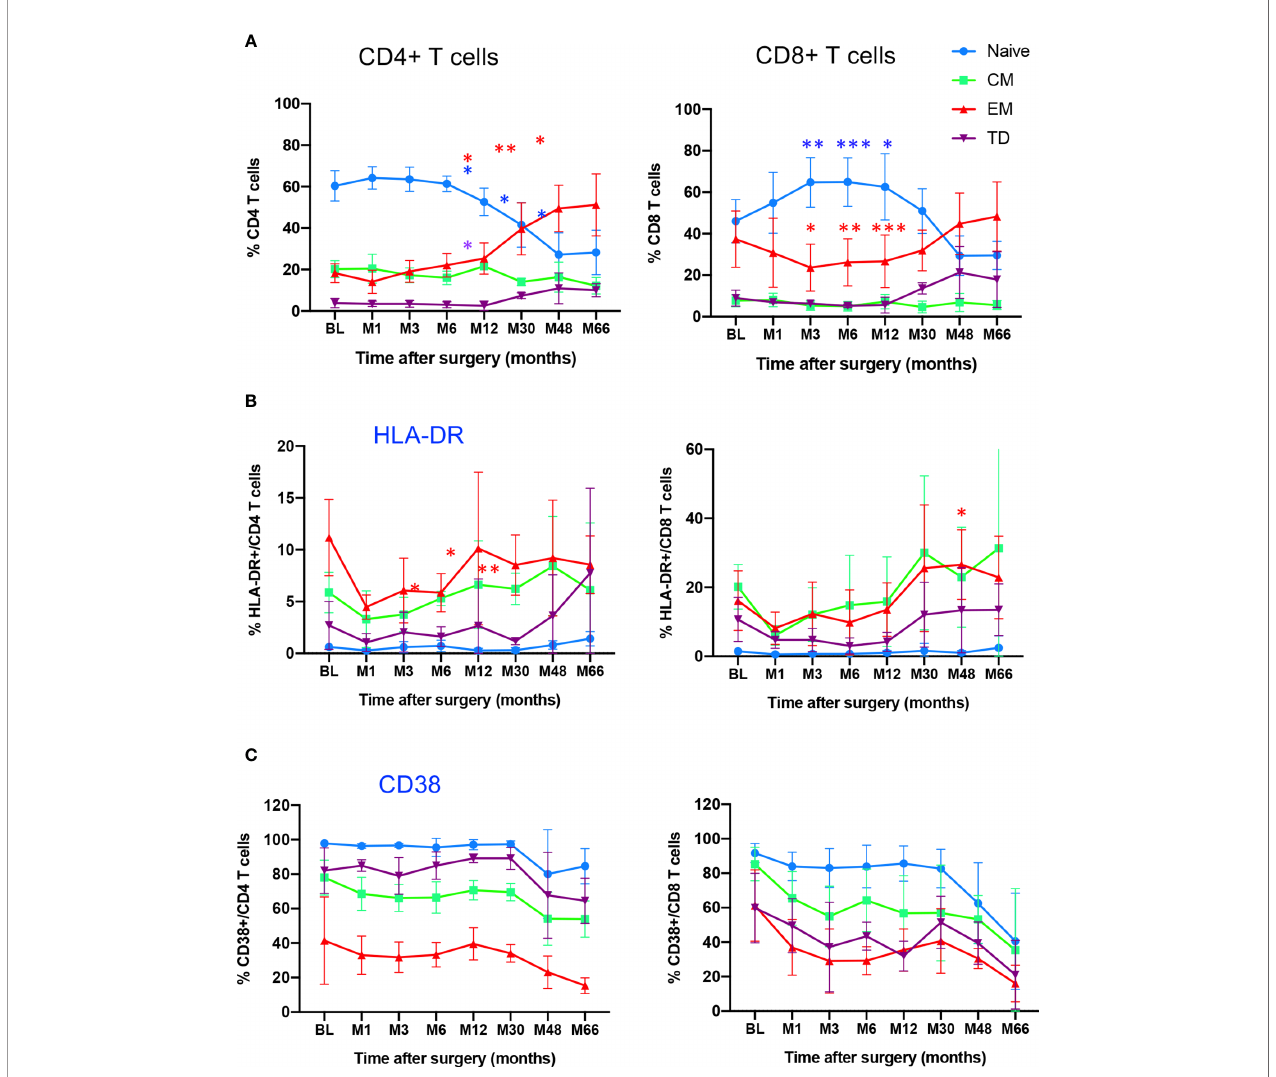
FIGURE 2 | Time course distribution and activation state of memory/effector CD4 + and CD8 + T cells. (A) Whole blood distribution of naïve/memory/effector subsets in CD4 + and CD8 + T cells. The percentage of cell subsets within CD4 + and CD8 + T cells are shown at indicated time points. (B) HLA-DR expression in indicated subsets within CD4 + and CD8 + T cells. (C) CD38 expression in indicated subsets within CD4 + and CD8 + T cells. N, naïve, CM, Central Memory; EM, Effector Memory; TD, Terminally Differentiated, identi fi ed through CD45RA/CCR7 expression. Mean value ± SD are shown. Statistical comparisons for each time point vs baseline are indicated. *0.01 <p< 0.05, **0.001<p< 0.01,